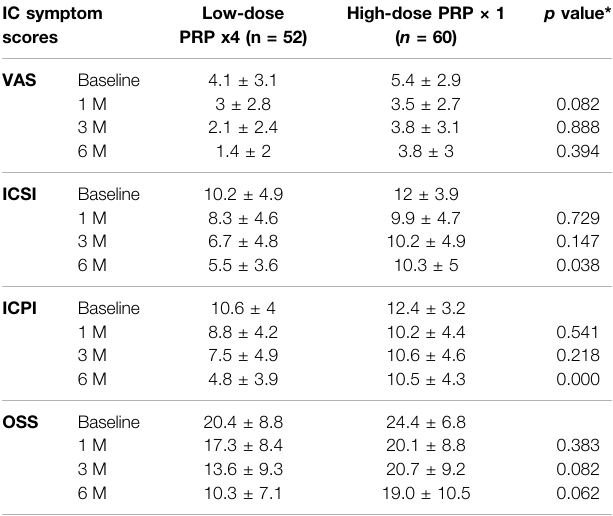
TABLE4| ChangesinmeasuredICsymptomscoreparametersamongtreatment groups from baseline to end-points. IC symptom